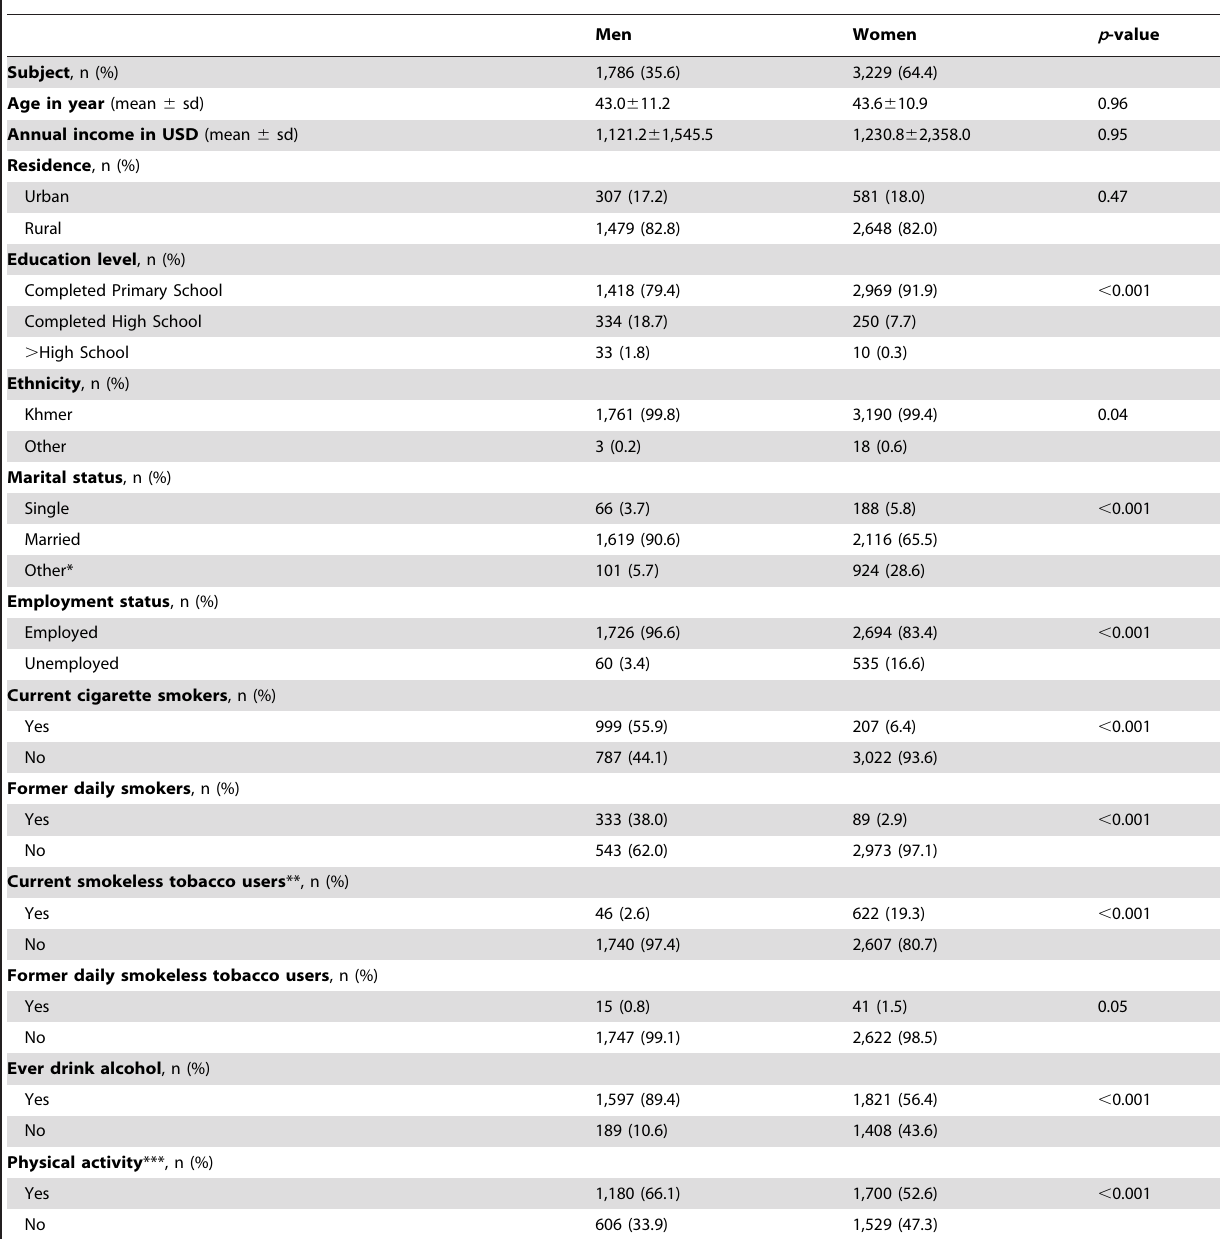
Table 1. Socio-demographic of